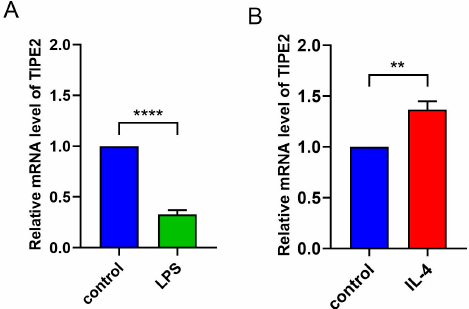
Figure 5. mRNA levels of TIPE2 in M1 and M2 macrophages. ( A , B ) The expression of TIPE2 mRNA was significantly decreased in M1 polarization induced by LPS ( p < 0.0001 ), but increased in the process of polarization to the M2 type ( p = 0.0016) (** p < 0.01, **** p < 0.0001).